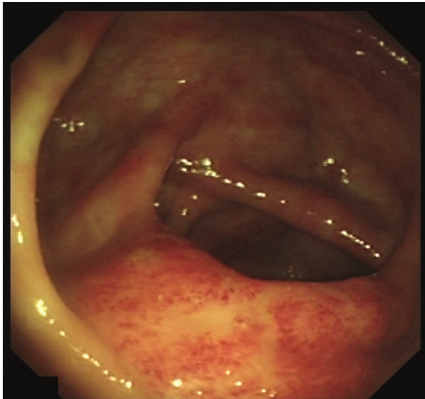
Figure 4: Cecal base showing patchy erythematous and petechial mucosa predominantly over the Ileocecal valve.